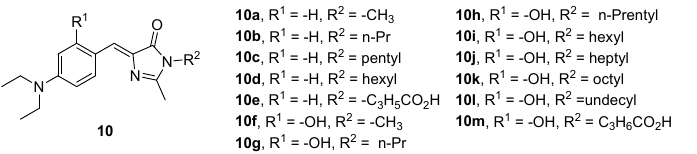
Figure 11. GFPc analogue with enhanced emission when encapsulated in NaCh vesicles [25]. sion inside the cavity of the β -cyclodextrin. inclusion inside the cavity of the β -cyclodextrin.